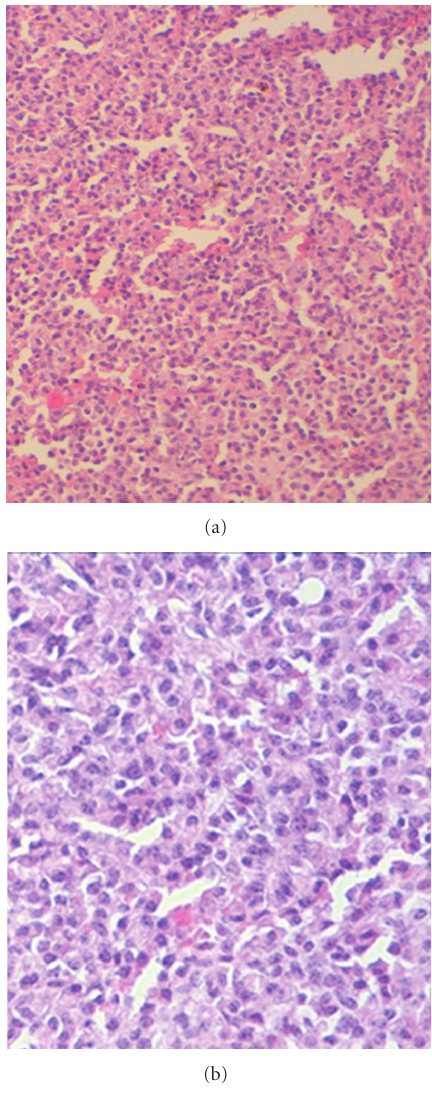
Figure 2: (a) and (b) thyroid parenchyma is infiltrated by a di ff use sheet of neoplastic cells that have an abundant cytoplasm and an eccentric and irregular